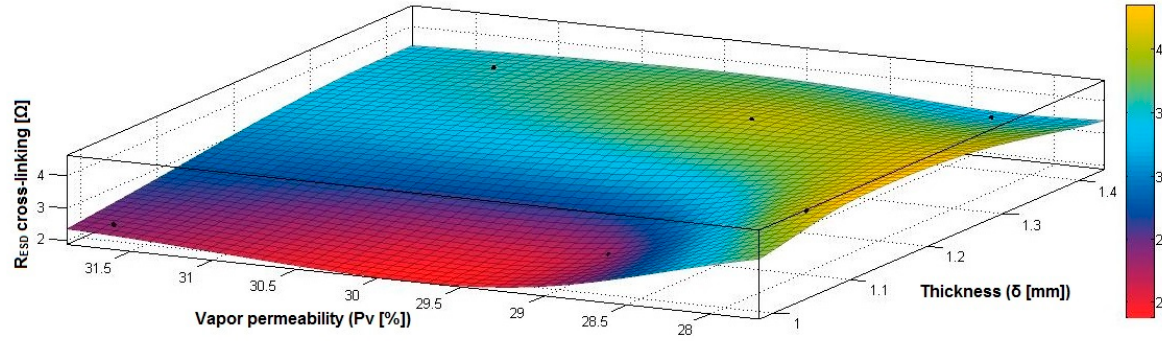
Figure 40. 3D representation R ESD after crosslinking = f(Pv, δ ) samples preliminarily treated in RF plasma O 2 using RF 2 generator and power 50 W.